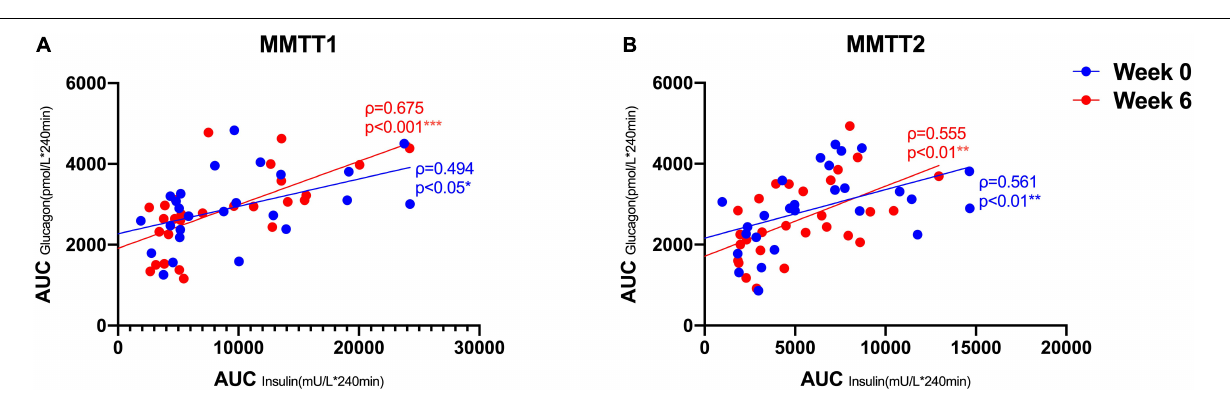
FIGURE 4 | Correlations between AUC (*240 min) insulin and AUC (*240 min) GCGN in MMTT 1 (A) and MMTT 2 (B) before (Week 0, blue) and after the intervention (Week 6, red). * p < 0.05; ** p < 0.01; *** p < 0.001.